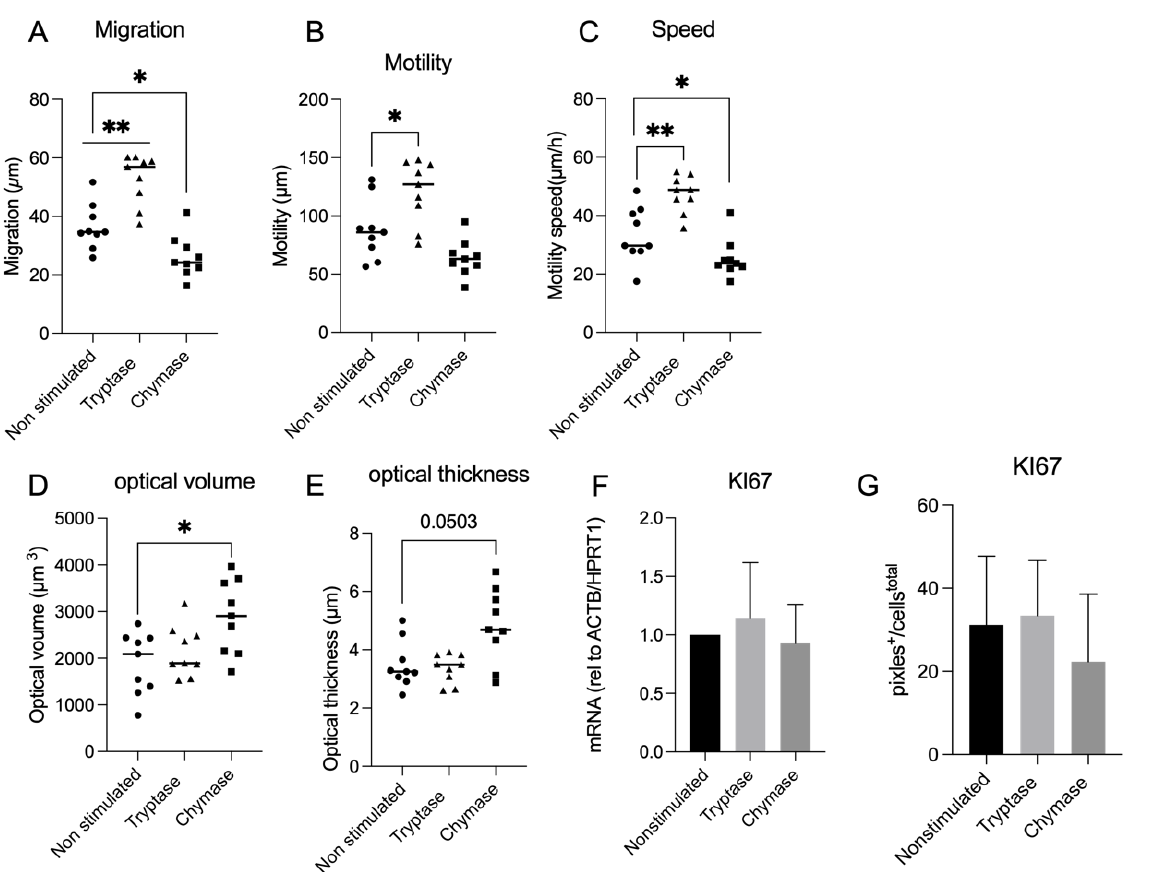
Figure 2. Chymase reduced and tryptase enhanced the migrated distance in µm from start point to end point (linear distance) compared to non-stimulated cells ( A ). Tryptase also enhanced the motility (total migrated distance in µm) compared to both chymase and non-stimulated cells ( B ). Tryptase increased the cellular speed (µm/h) compared to non-stimulated cells and chymase decreased the cellular speed compared to non-stimulated cells ( C ). Chymase stimulated cells displayed altered morphology in terms of optical volume compared to tryptase and non-stimulated cells ( D ) and chymase stimulated cells also displayed a trend of enriched optical thickness compared to both tryptase and non-stimulated cells ( E ). mRNA and protein expression of proliferation marker Ki67 did not display any significant difference between the groups ( F , G ). Statistical significance between non-stimulated and tryptase and non-stimulated and chymase stimulated was tested using the Mann–Whitney test. Data represent mean (SD). * p < 0.05, ** p < 0.01. Data are based on a minimum of three technical repeats.